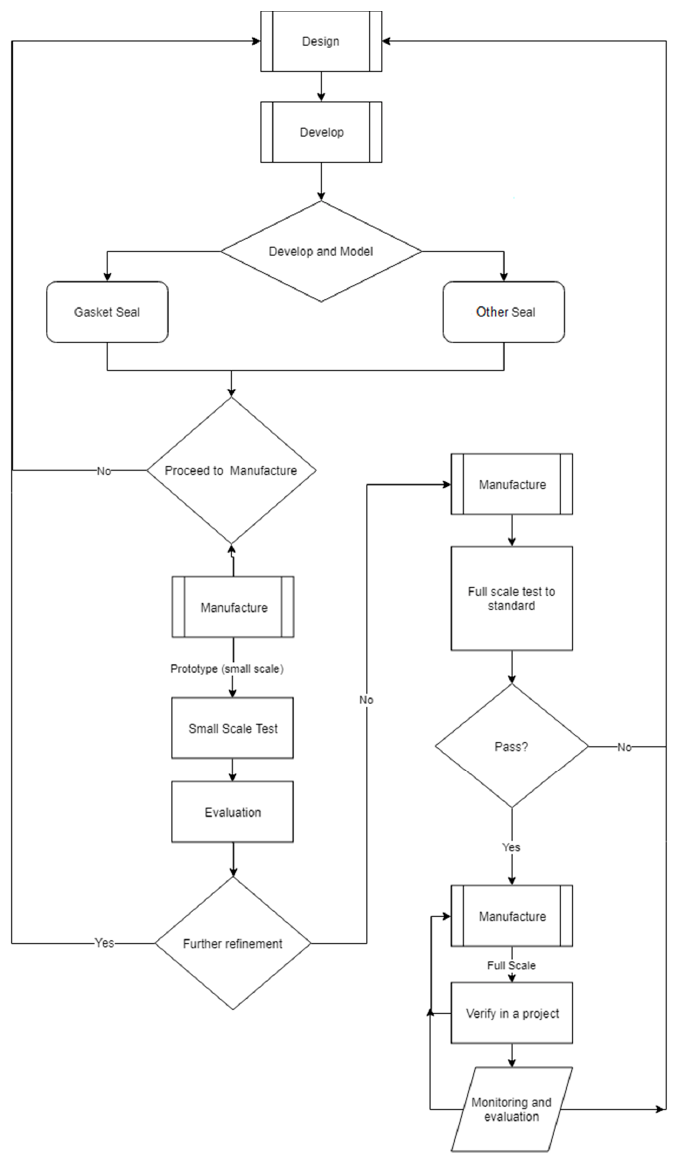
Figure 3. High level overview flowchart of the method used.